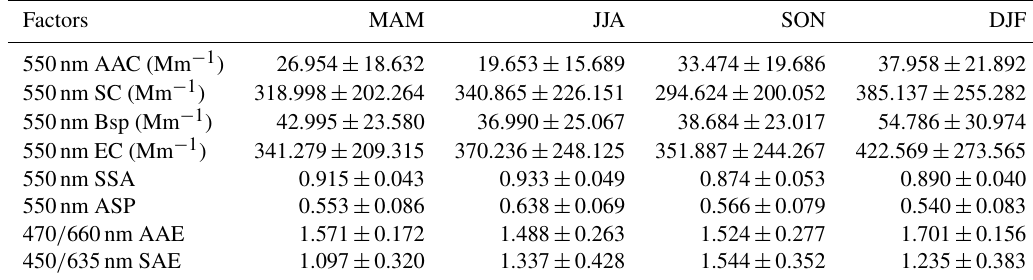
Table 2. Seasonal mean ± SD of the surface aerosol optical properties in Nanjing. Factors MAM